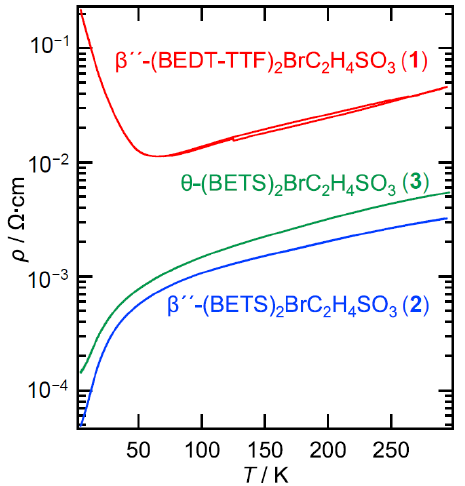
Figure 4. Temperature-dependent electrical resistivities of 1 , 2 , and 3